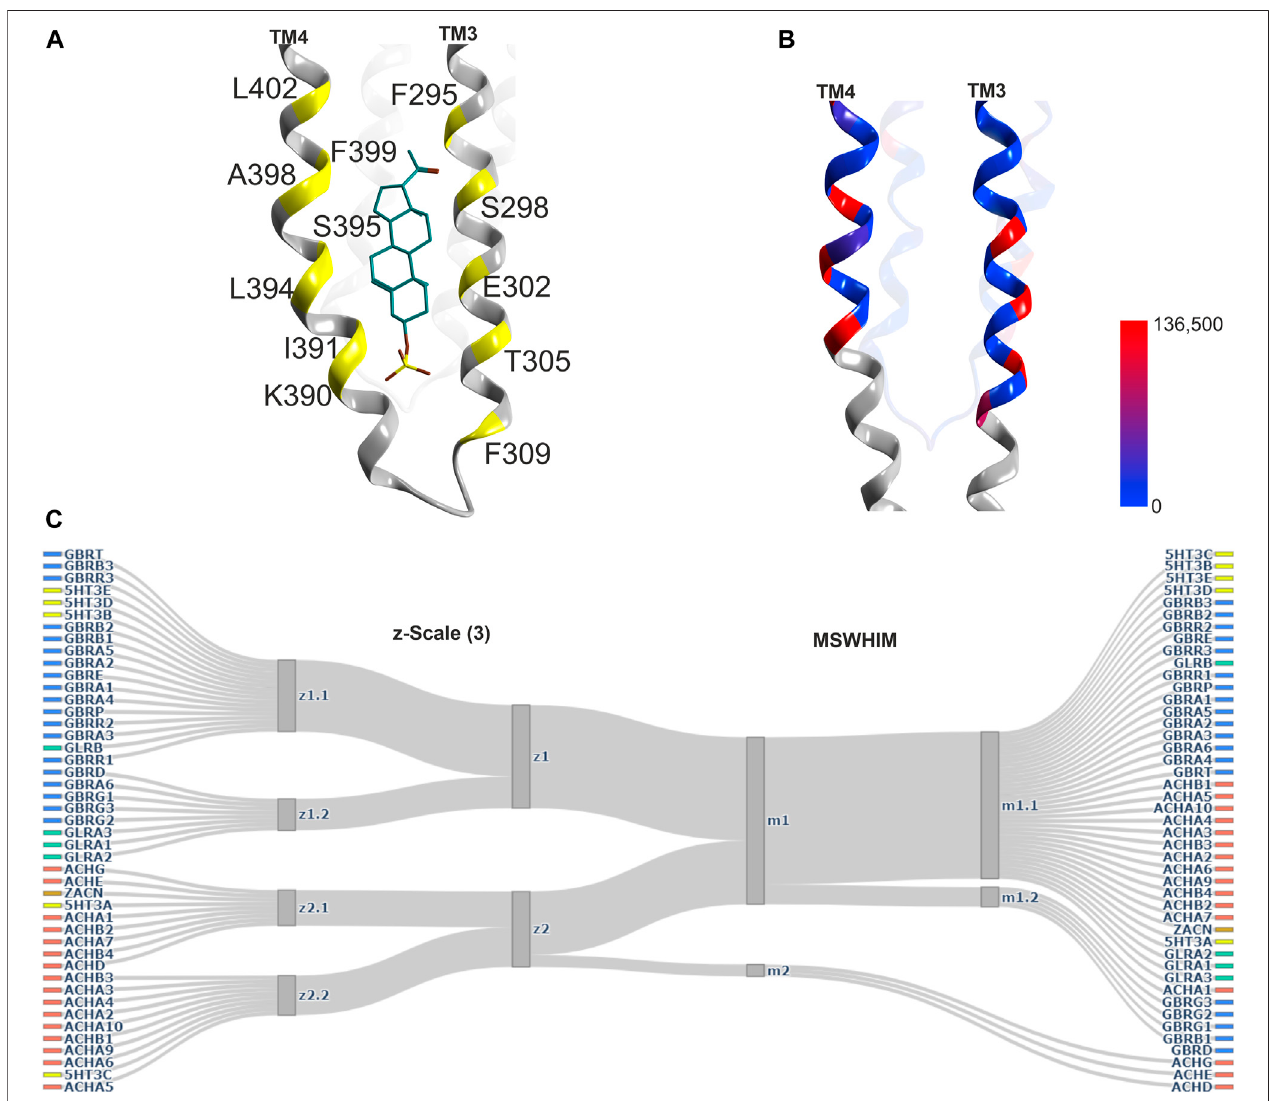
FIGURE 7 | Representative structures of the lipid/TM3/TM4 associated site, and descriptor analysis: (A) Ribbon of the 5OSC structure with pregnanolone sulfate bound.The yellow places on the ribbon indicate the binding site forming positionswhich were used for thepocket analysiscomputations. (B) Amount of variants across allgenesofinterestintheregionofthisbindingsitemappedonto7EKT.Ribbonheatmaprepresentsthesumofminorallelecountsper100,000ateachalignedposition. See Supplementary Figures S18,S19 for detailed heatmaps. (D) Comparison diagrams derived from hierarchical clustering of z-Scale(3) and MSWHIM descriptors as estimates for similarities. Supplementary Figure 16 depicts the full dendrograms.